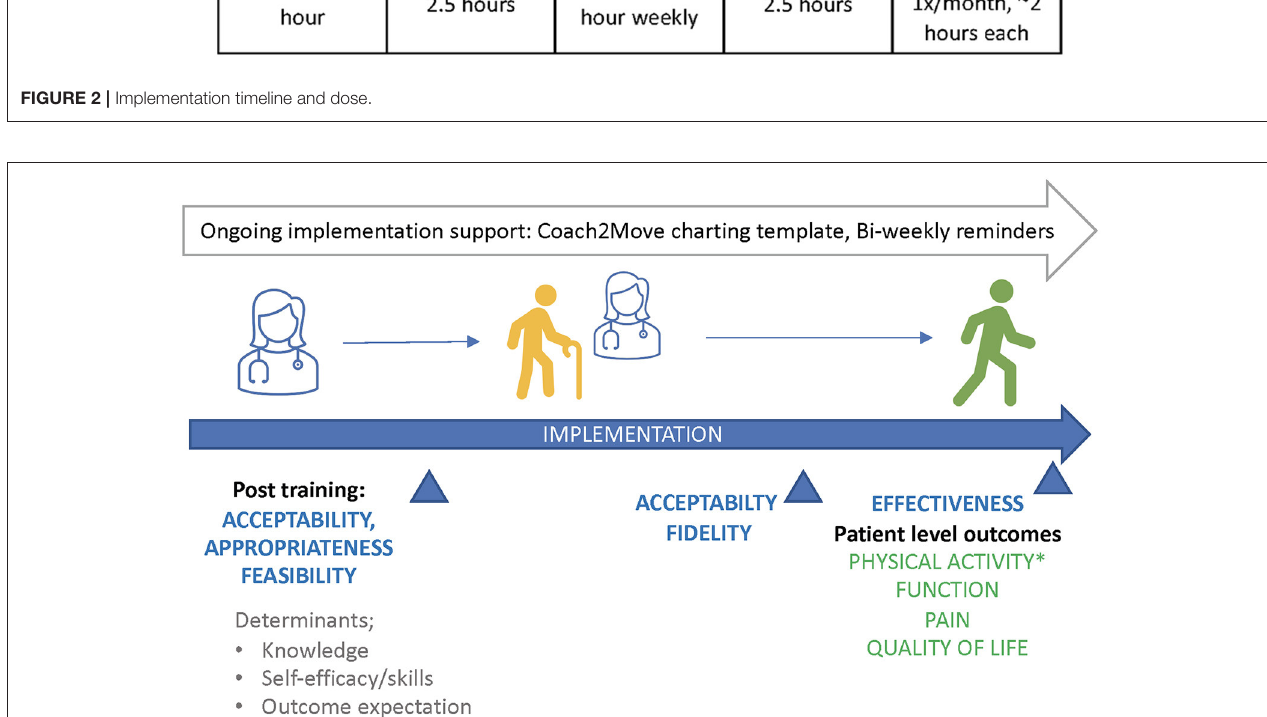
FIGURE 3 | Implementation outcomes and timeline for